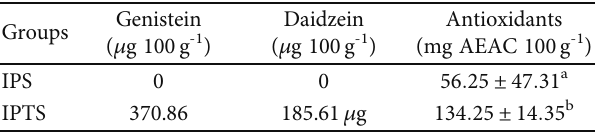
Table 1: The results of the analysis of iso fl avones and antioxidant